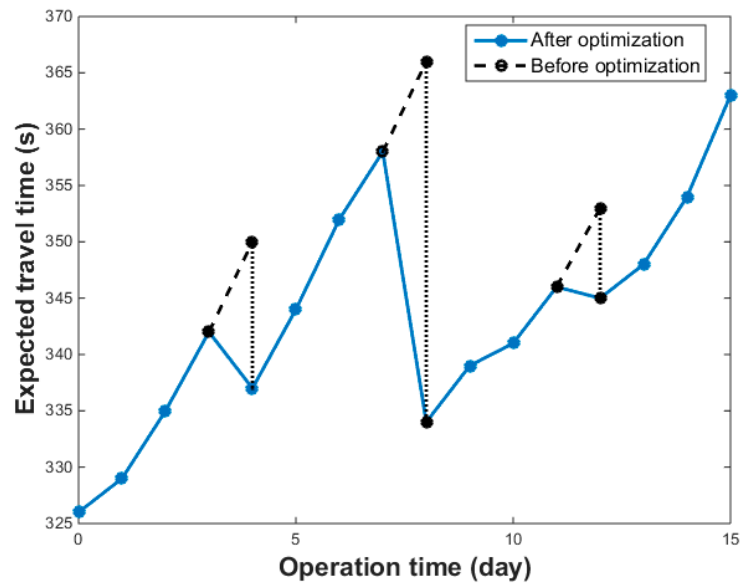
Figure 18. Expected travel time change with incorporating reliability and maintenance levels.